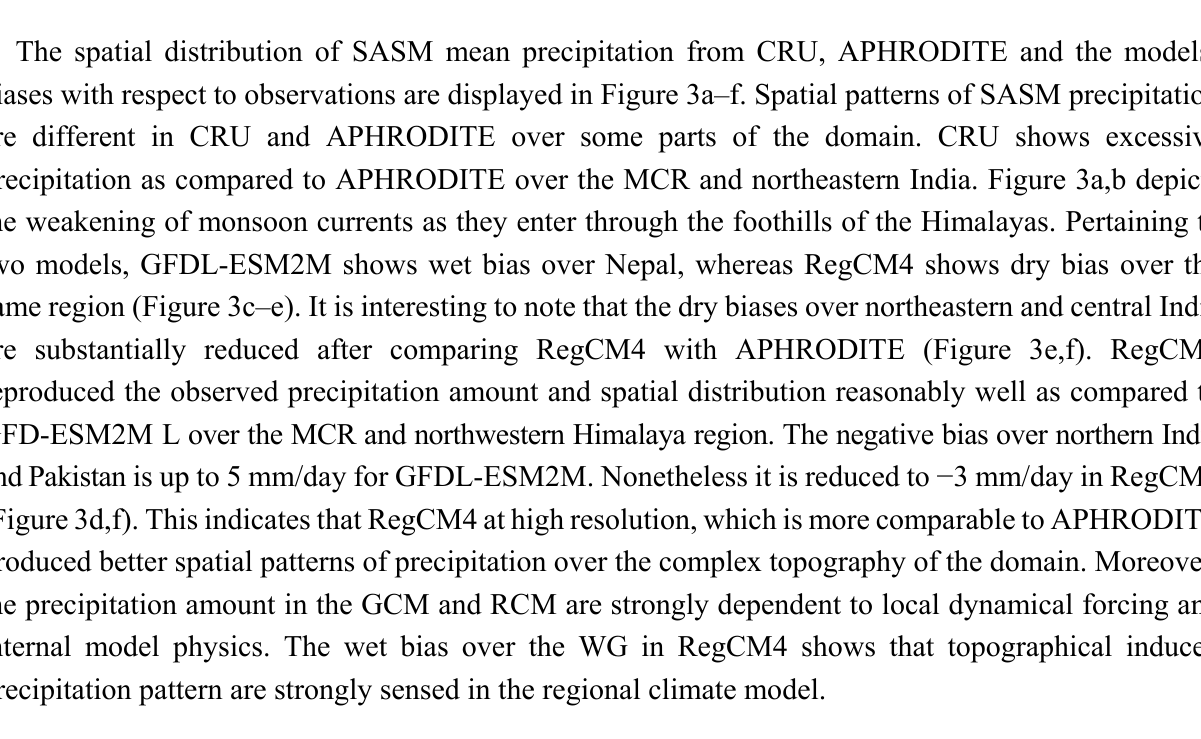
Figure 2. Spatial distribution of summer mean surface air temperature (°C) for ( a , b ) CRU and APHRODITE observations; ( c , d ) GFDL-ESM2M and ( e,f ) RegCM4 model biases with respect to